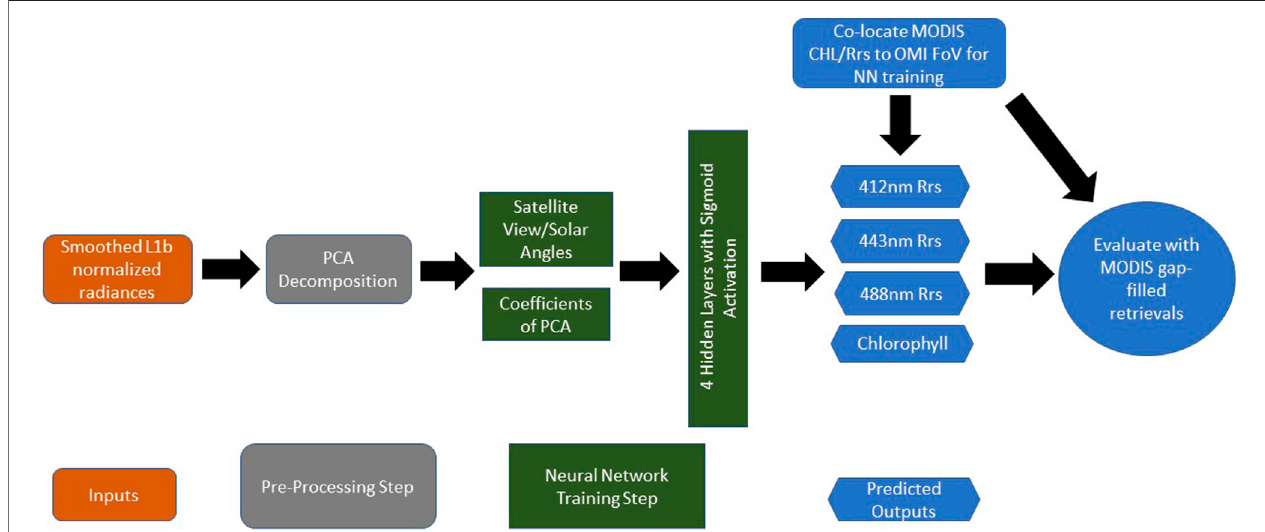
FIGURE 4 | Flowchart showing how hyperspectral TOA radiances from OMI and TROPOMI are used to train a neural network to predict ocean color information using ocean color data from MODIS as the training dataset. A single neural network is used to predict all four outputs (details discussed in text).